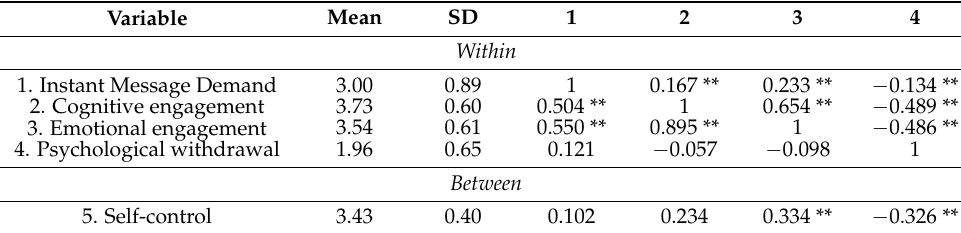
Table 1. Means, SDs, and intercorrelations among study